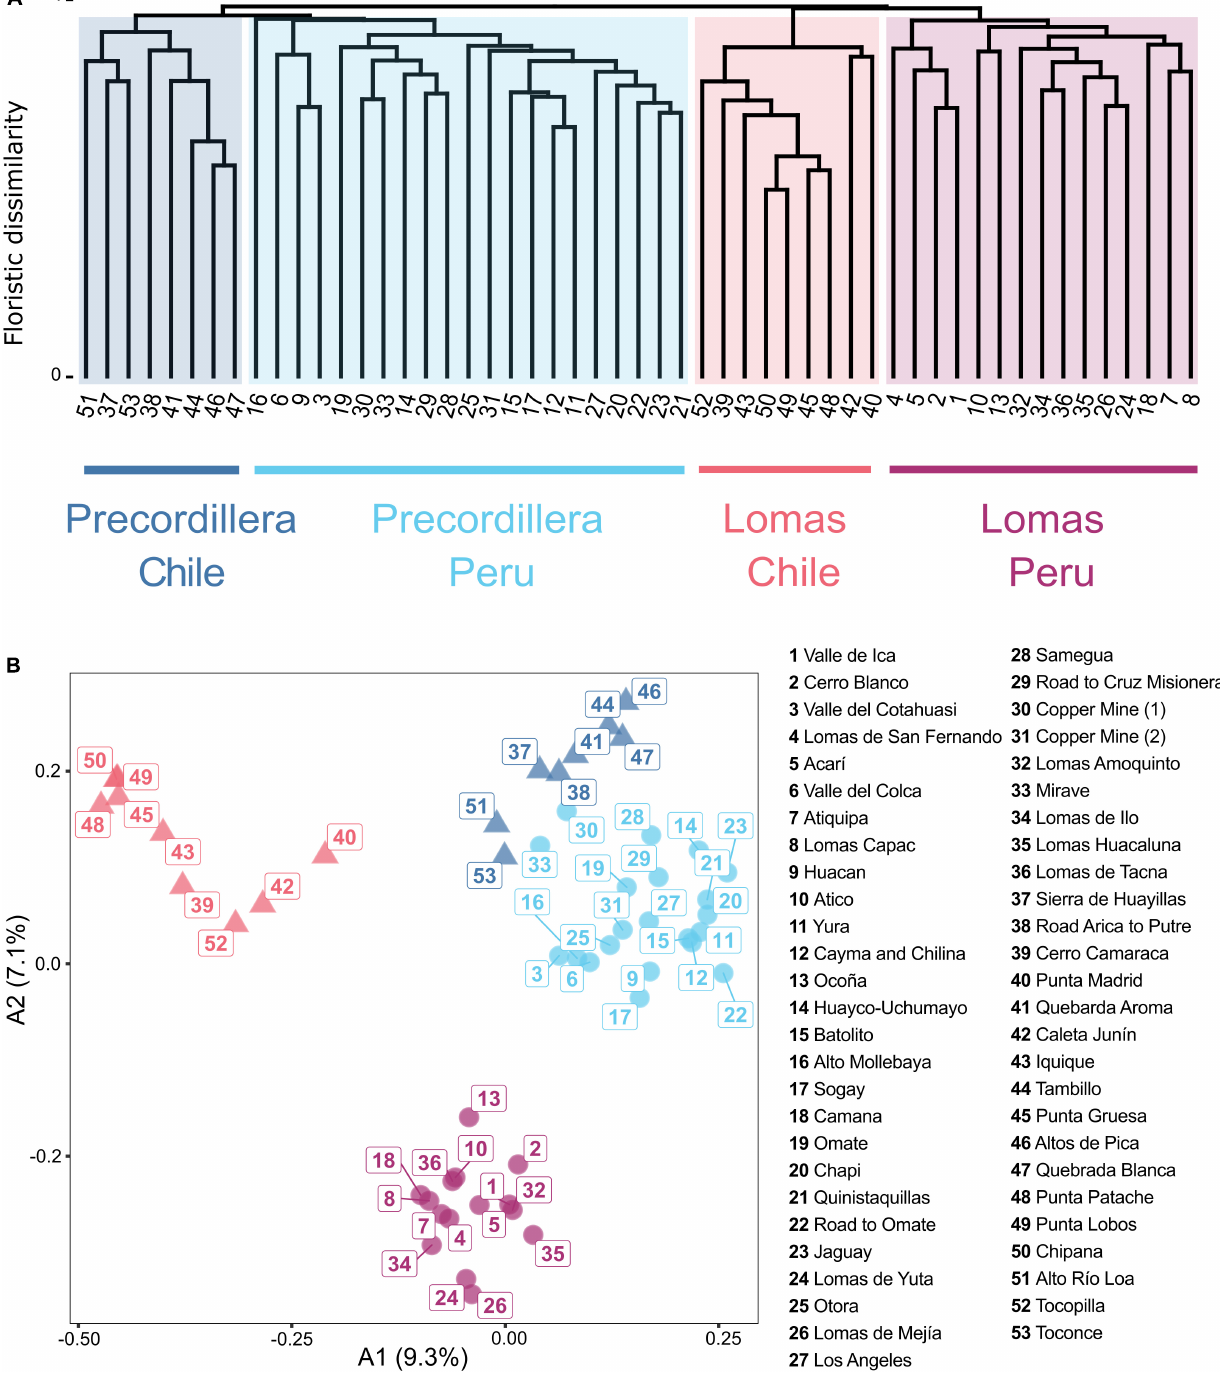
Frontiers in Ecology and Evolution |